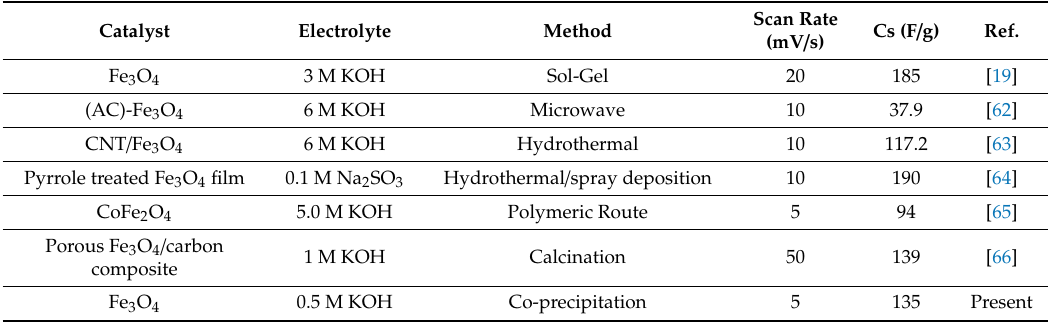
Figure 9. ( a ) Cyclic voltammograms at 5 to 100 mV / s scan rates, ( b ) Specific capacitances of the MIONPs electrode as a function of scan rate and ( c ) charge / discharge profile of MIONPs. Table 1. Comparison of specific capacitances with electrochemical parameters of as-acquired MIONPs with the literature.